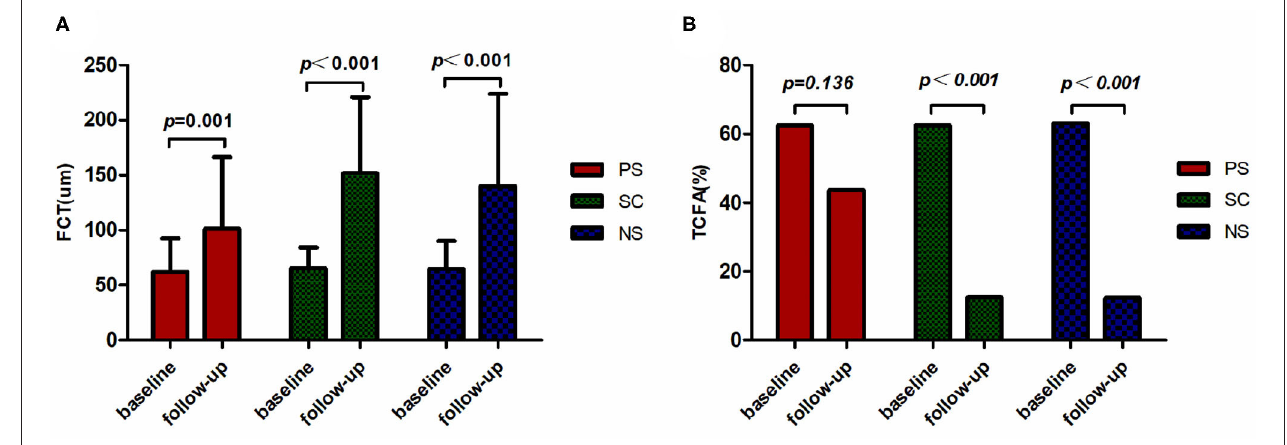
FIGURE 4 | Changes in FCT and TCFA. The FCT (A) and incidence of TCFA (B) assessed by OCT at two time points are presented for each group. The FCT in all three groups was larger at the 1-year follow-up. The incidence of TCFA at 1 year declined relative to the baseline in the SC and NS groups. FCT, fibrous cap thickness; TCFA, thin-cap fibroatheroma; PS, persistent smoking; SC, smoking cessation; NS,